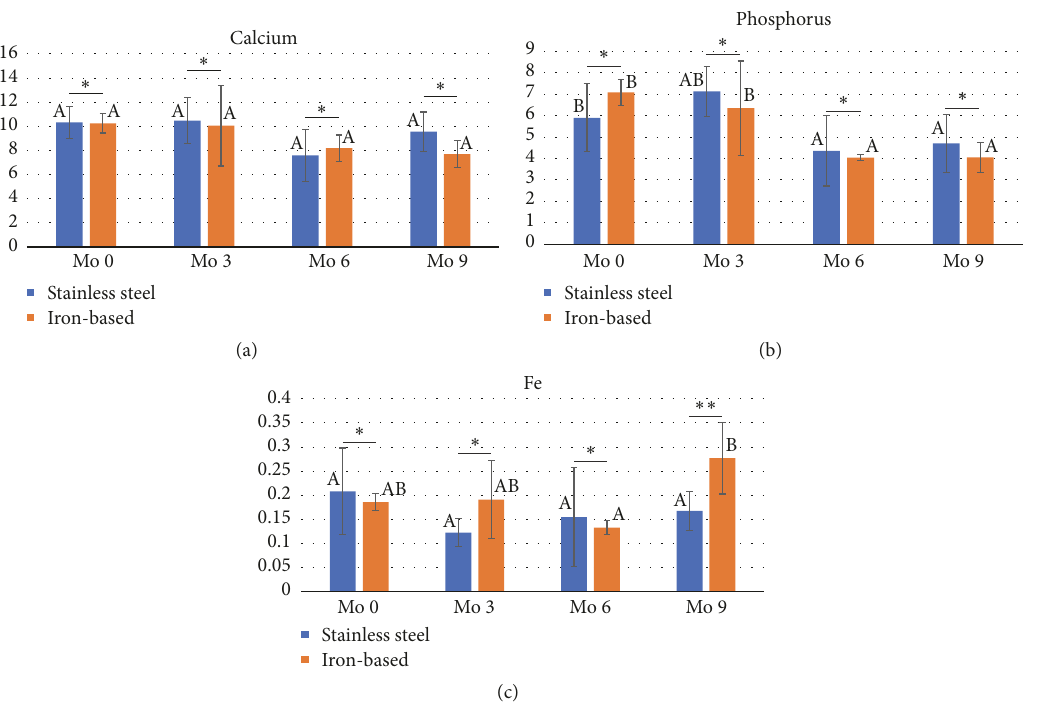
Figure 3: Mineral concentration of iron-based implant in tibial shaft fracture during 9 months’ observation time after implantation in sheep (a) calcium, (b) phosphorus, and (c) iron concentration. The same superscript letters (A, B) in same group showed no significant differences during observation time, ∗ insignificant differences and ∗∗ significant difference between both groups in same observation times (P > 0.05). Mo: